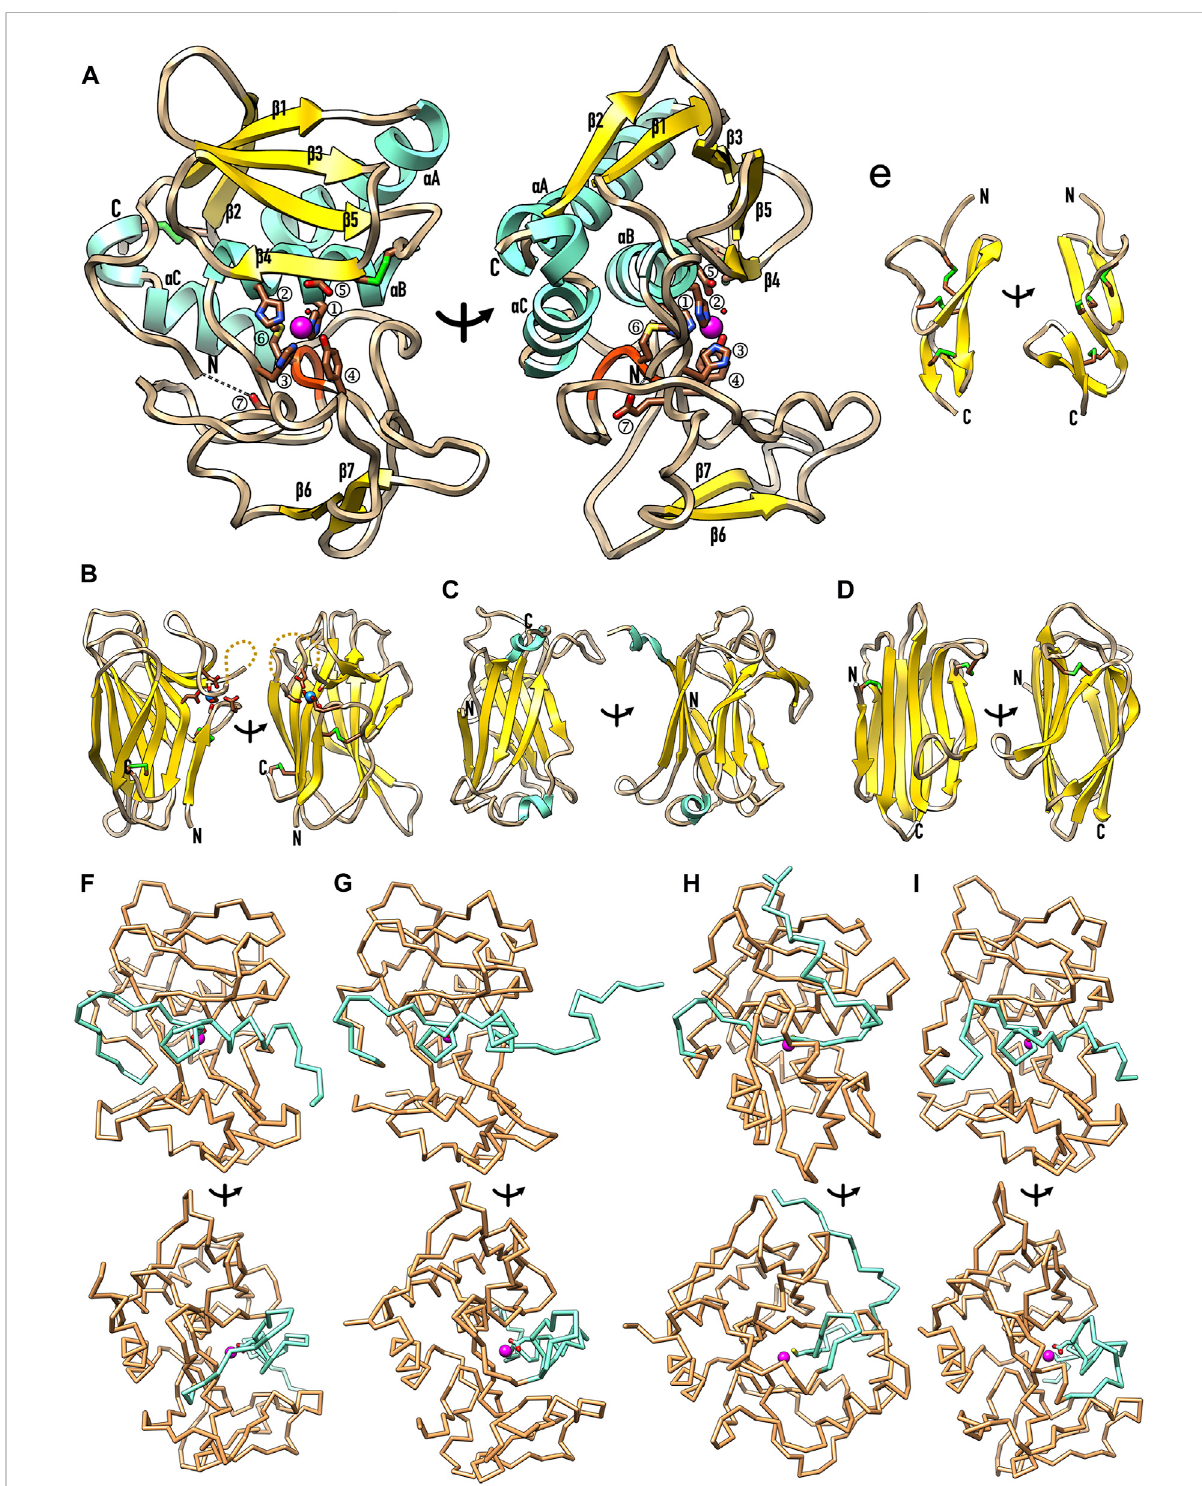
FIGURE 2 Representative structures of the most relevant astacin domains. (A) Ribbon-type plot of the mature Astacus astacus cray fi sh astacin catalytic domain [PDB 1AST;residues50 – 251,see UniProt P07584; (Bode etal., 1992;Gomis-Rüth etal., 1993)], which is shown inthestandardorientation of